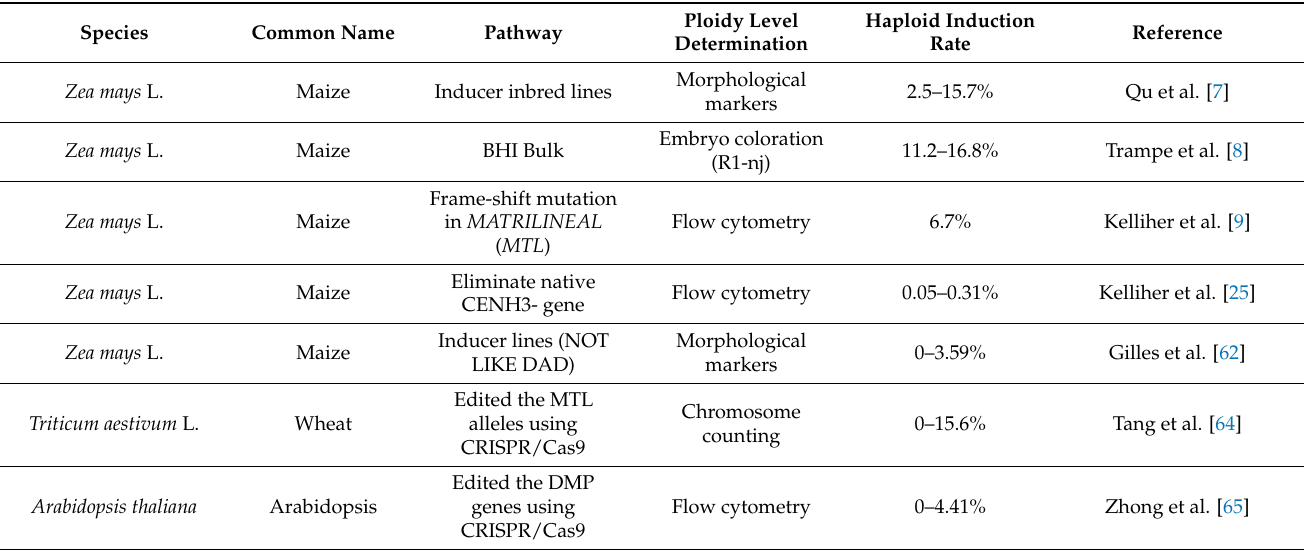
Table 5. Summary of haploid induction reports via in vivo haploid